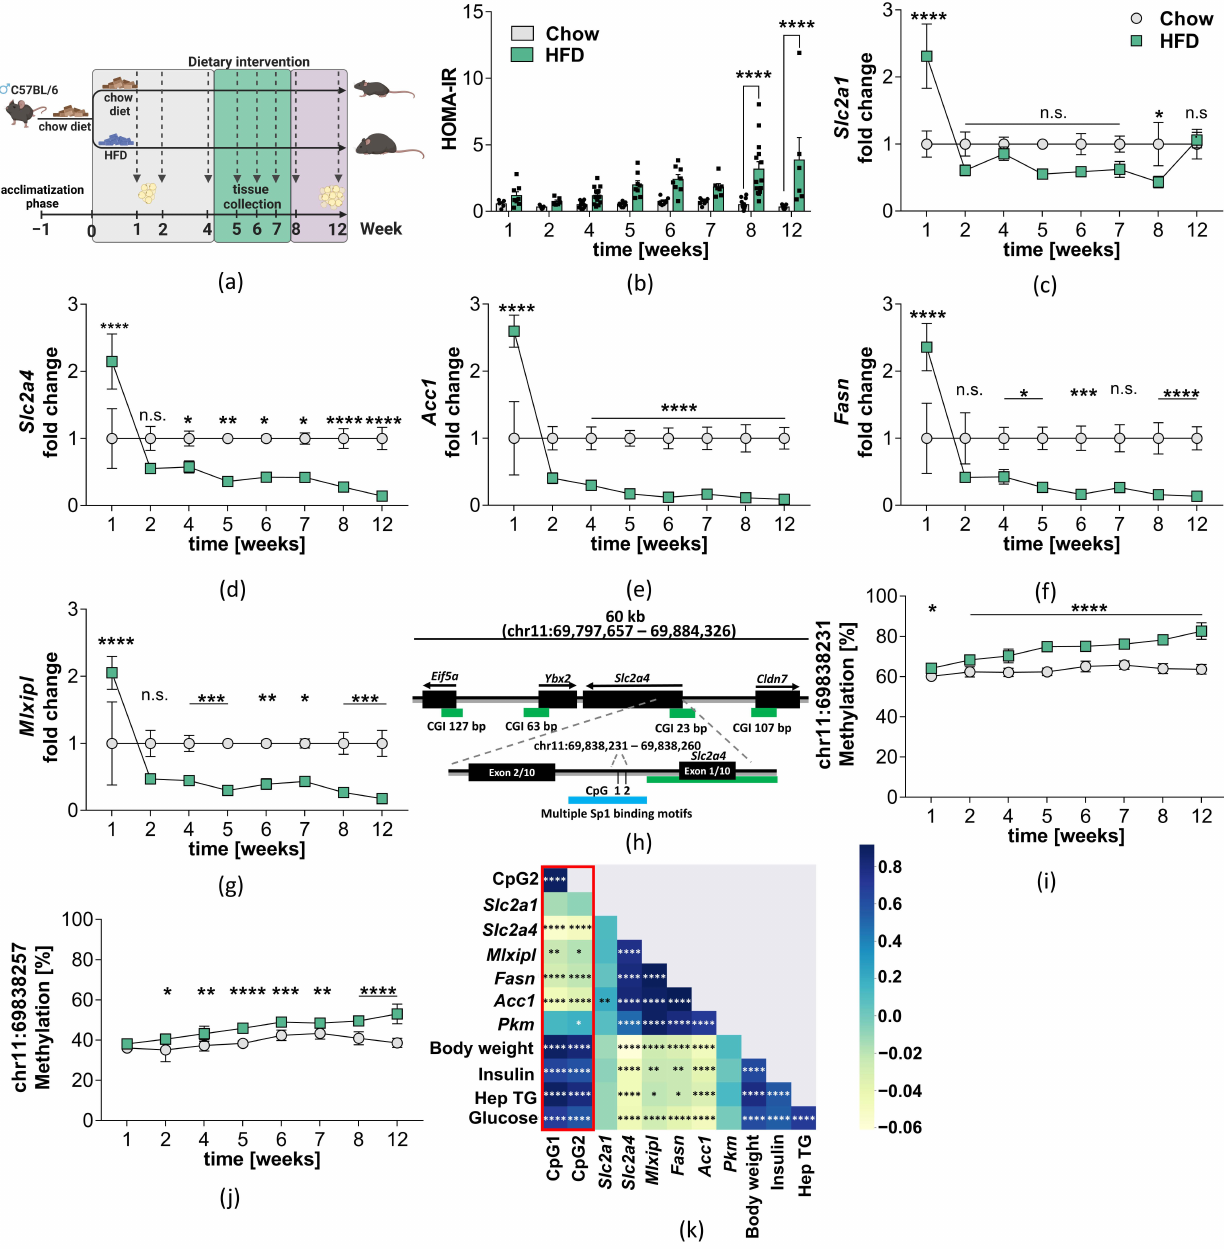
Figure 3. Gene expression and DNA methylation of the Slc2a4 gene in VAT of DIO mice fed a high-fat diet. ( a ) Feeding regime of high-fat mice over a period of 12 weeks. Time points of sacrifices are indicated in weeks. Colored background demonstrates stages of obesity and insulin resistance in HFD mice, with grey = lean; green = obese; purple = obese and insulin-resistant; ( b ) HOMA-IR